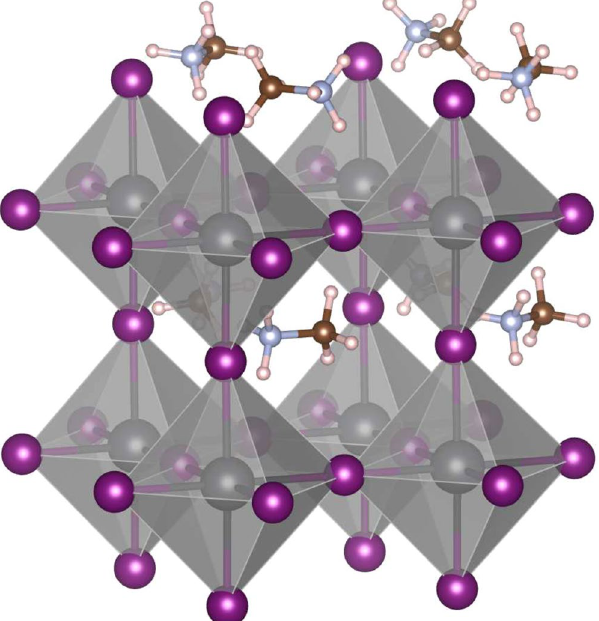
Figure 1. Structure of the perovskite material MAPbI 3 . The I atoms are located at the edges of the octahedra, with the Pb atoms at the centers of the octahedra and the MA molecules at the centers of the spaces between the octahedra. The disorder in the systems has two sources: (1) the random, and in fact temporally fluctuating, orientations of the MA molecules producing a random electrostatic potential landscape in the lattice and (2) the substitutional halide atoms, i.e. Br atoms replacing some of the I